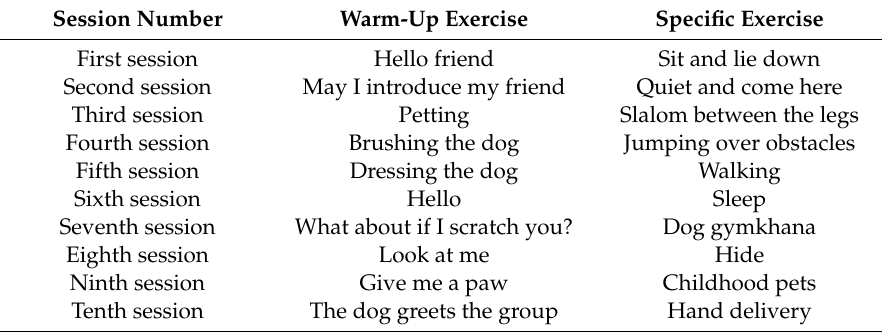
Table 2. Animal-assisted therapy sessions